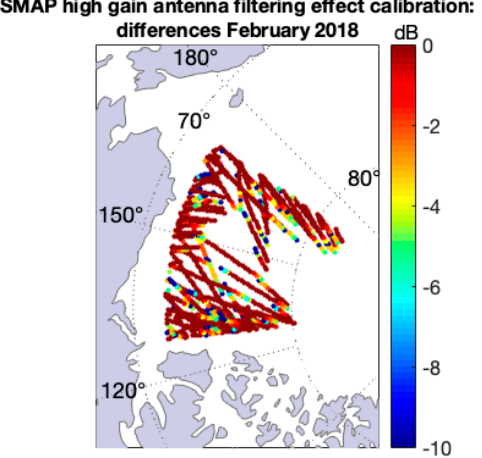
Figure 17. Impact of the SMAP antenna high gain filtering effect calibration for February 2018 data. Up to 10 dB total difference correction is observed. The larger errors correspond to reflections farther away from the SMAP antenna boresight. This correction applies to both H-pol and V-pol.